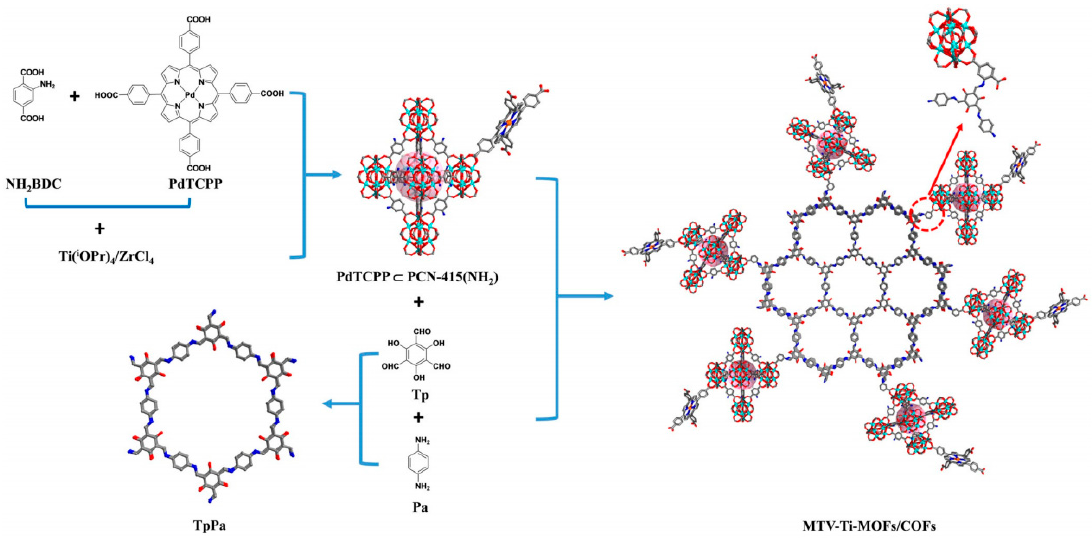
Figure 13. The schematic diagram of the synthesis steps for MTV-Ti-MOF/COF. Reproduced with permission from Ref. [80].